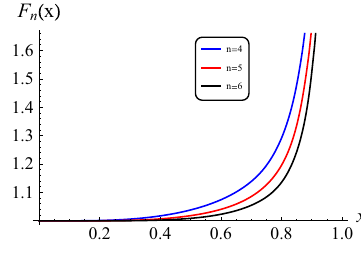
Fig. 2 F ( x ) − x diagram for diffrent